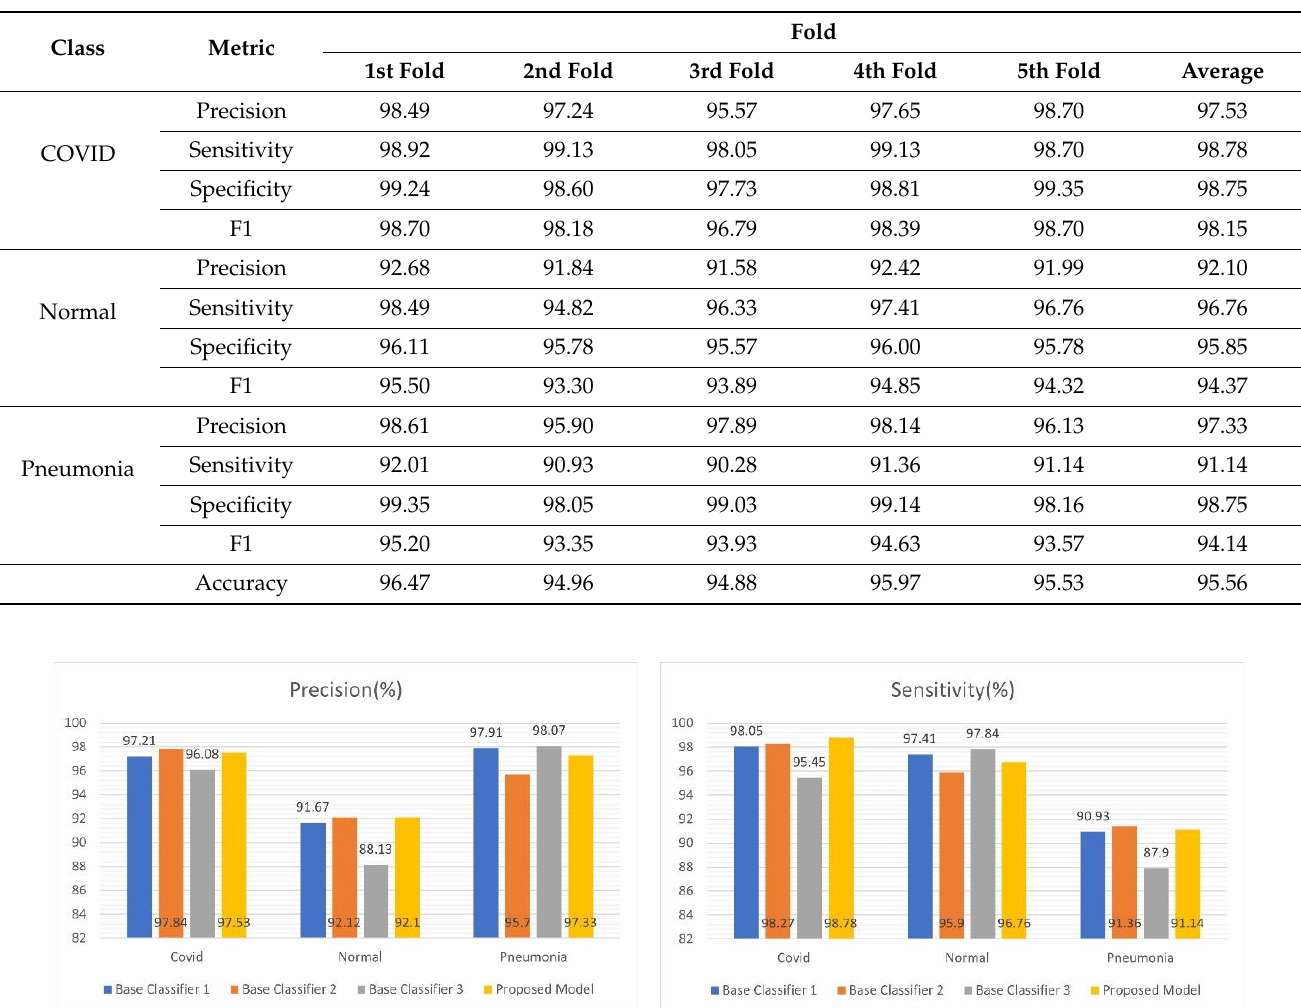
Table 5. The performance of the final proposed architecture, COVIDX-LwNet, at each compromise (D1, 3 class).